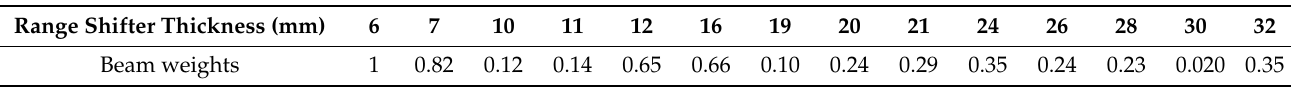
Table 3. Range shifter thicknesses (mm) and pristine peak weights for the simulation of the HIBMC SOBP 320 MeV/n carbon-ion beam line using